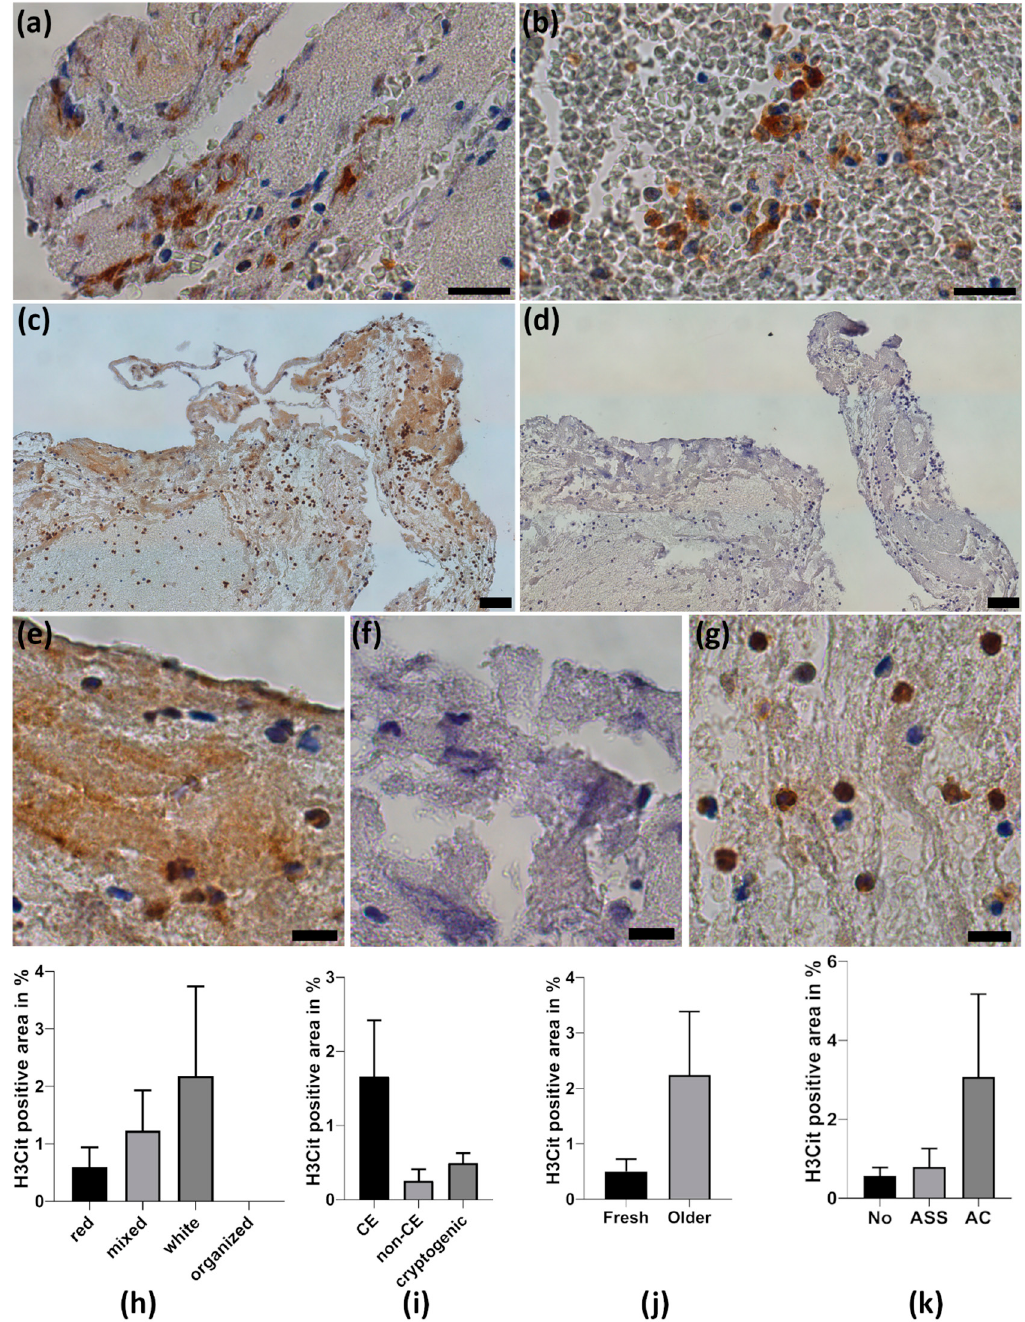
Figure 3. Neutrophil extracellular traps in thrombemboli. ( a , b ) Representative H3Cit stained thrombemboli. ( a ) Magnifications of web-like neutrophil extracellular traps (NETs) within fibrin-rich structures and ( b ) web-like NETs in RBC-dominating area. ( c ) Cerebral thrombembolus with a vast amount of H3Cit-positive area and control staining with IgG ( d ). ( e ) Magnification illustrates the presence of H3Cit-positive area identified by its brown color in contrast to IgG control ( f ) and intracellular H3Cit immunoreactivity in neutrophils ( g ). Counterstaining with hemalum dyes nuclear cells and DNA. H3Cit-positive area was quantified and is presented according to thrombembolus morphology ( h ), stroke etiology ( i ), thrombembolus age ( j ) and pre-existing anticoagulant medication ( k ). ASA = acetylsalicylic acid, AC = anticoagulation. Scale bars: ( a , b ) 20 µm, ( c , d ) 50 µm; ( e , f , g ) 10 µm.